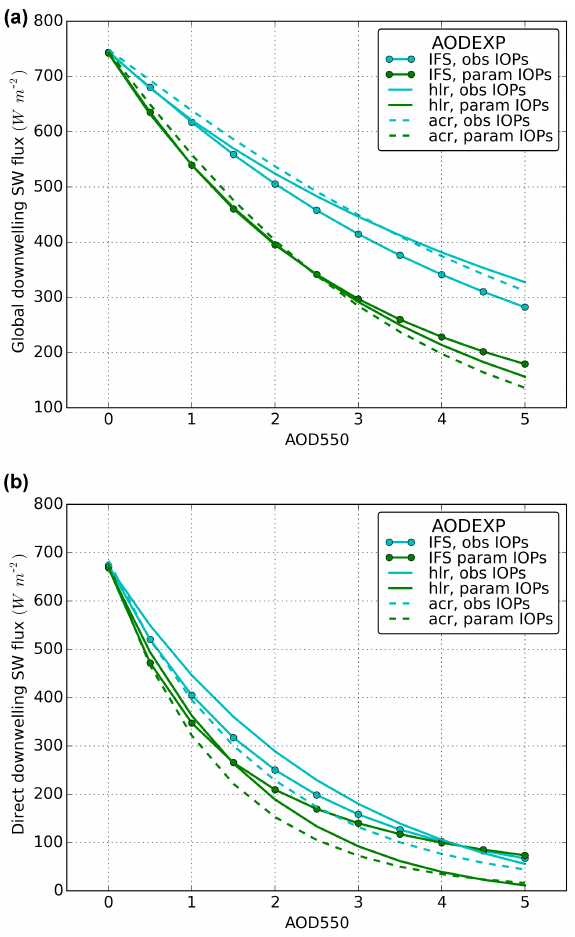
Figure 5. Global SWD flux as a function of AOD550 for MUSC experiments run using the IFS (dotted continuous curve), hlradia (continuous curve) and acraneb2 (dashed curve) radiation schemes. The results depicted by the cyan curves are for the cases where ob- served IOPs (SSA, g and AOD scaling) were used. Parameterised IOPs were used for those shown in green. The direct SWD flux for MUSC experiments using the same aerosol scenarios and radiation schemes as in panel (a) is shown in panel (b) .